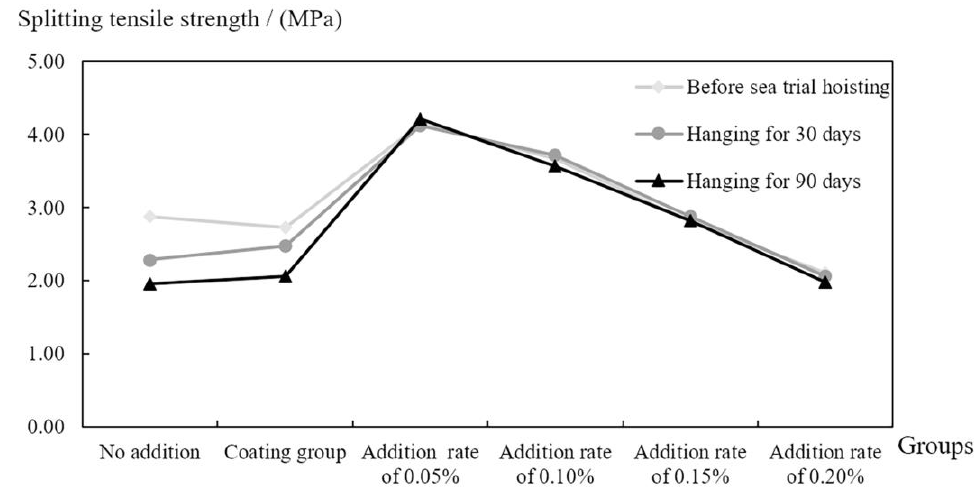
Figure 12. Folding line graph of changes in splitting tensile strength before and after sea experiments for each group.